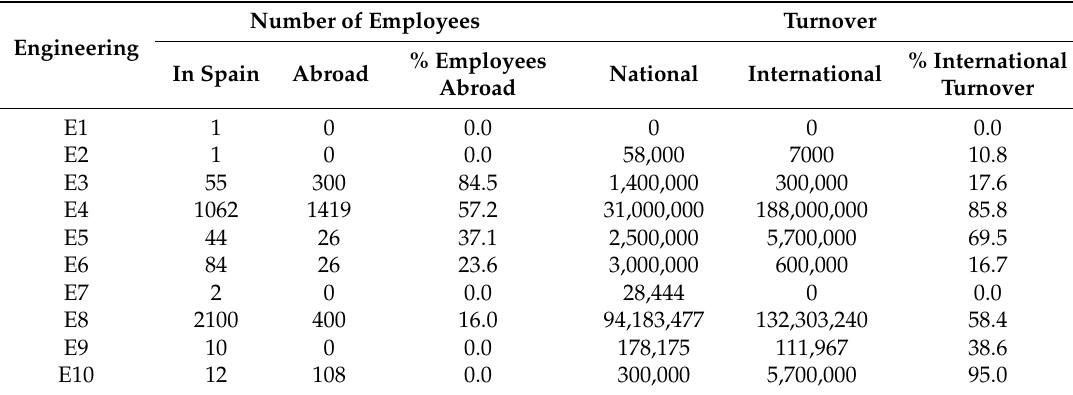
Table 3. Number of employees and turnover: in Spain and abroad.